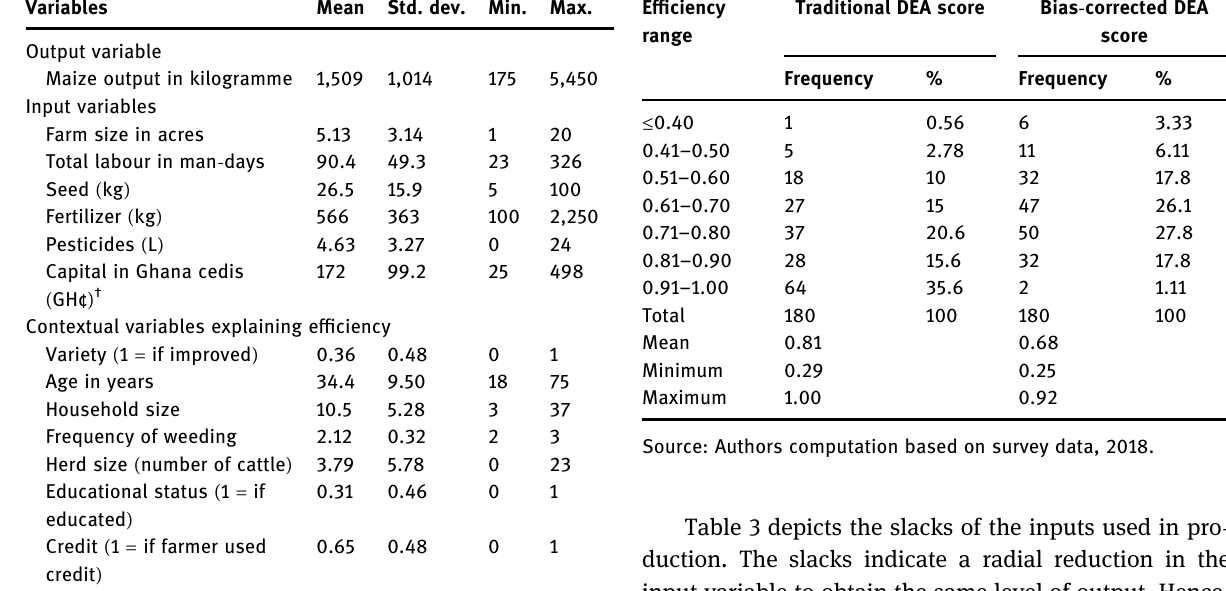
Table 1: Descriptive statistics of the variables Variables Mean Std. dev. Min. Max.